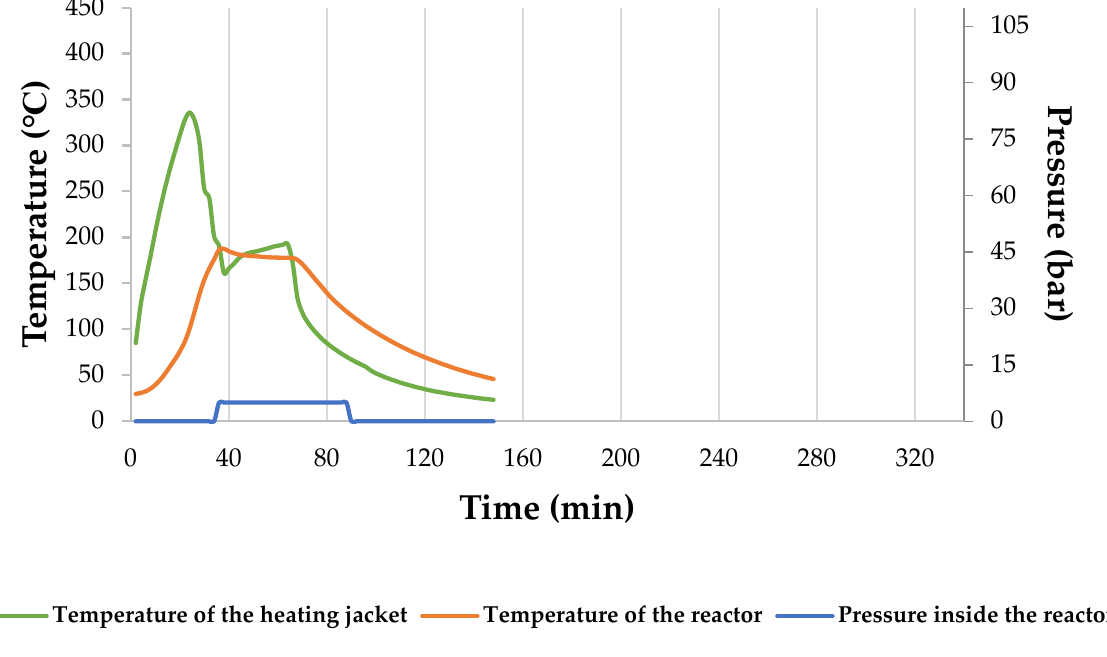
Figure A1. Temperature and pressure patterns during the process at 180 ◦ C in 30 min.